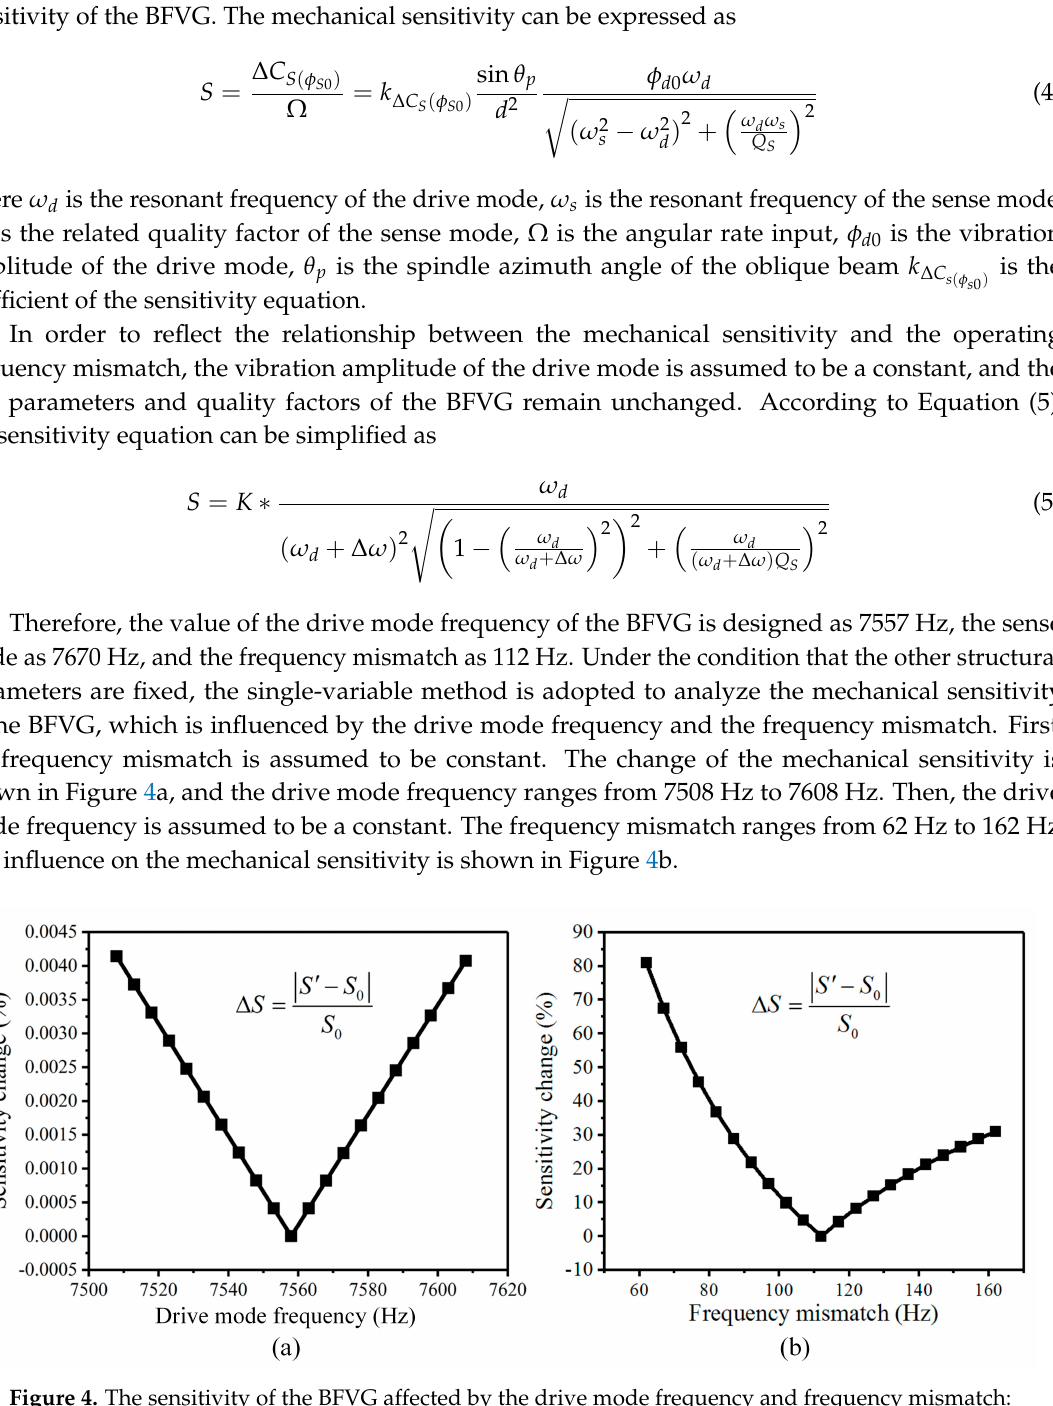
Figure 4. The sensitivity of the BFVG affected by the drive mode frequency and frequency mismatch: a ) The drive mode frequency; ( b ) the frequency ( a ) The drive mode frequency; ( b ) the frequency mismatch. (